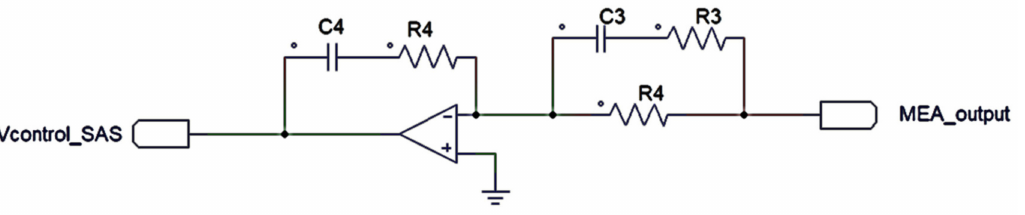
Figure 6. Lead–lag network.